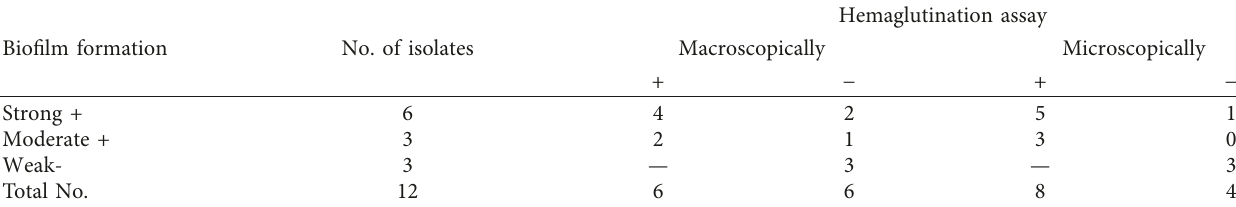
Table 7: The relationship between biofilm formation and hemagglutination assay in S. aureus .